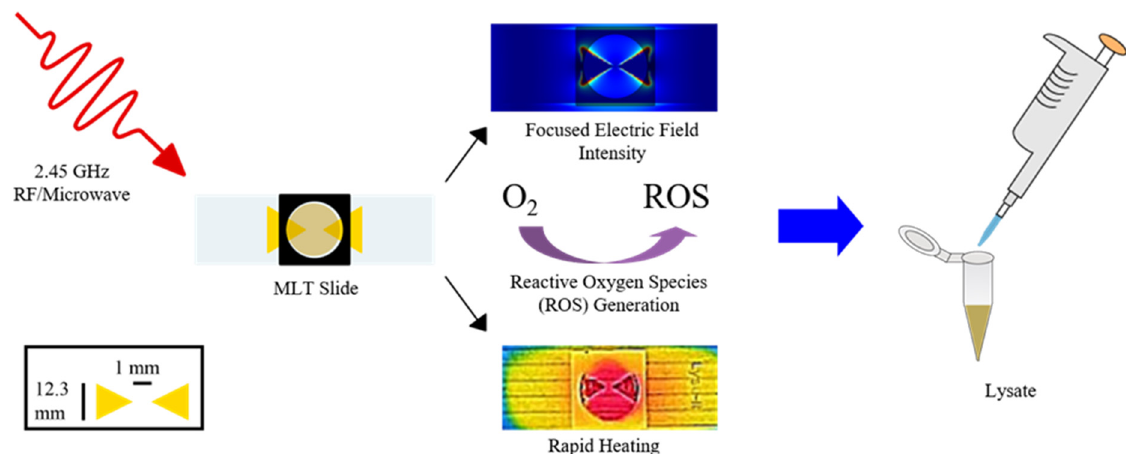
Molecules 2021 , 26 , x FOR PEER REVIEW 13 of 21